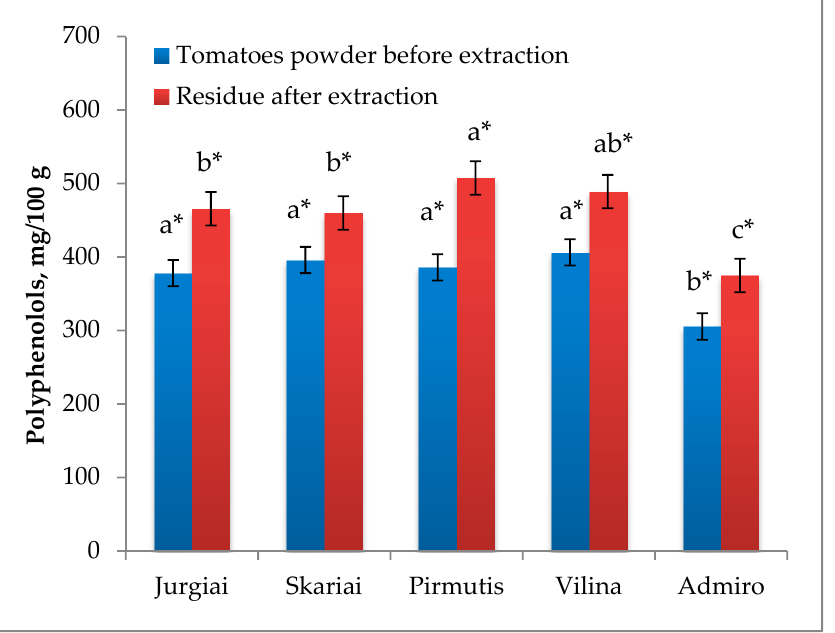
Figure 1. The total amount of polyphenols in tomato powders and residues after SCE-CO 2 extraction. * Different letters above the columns of the same color indicate significant differences between the measured values ( p ≤ 0.05).